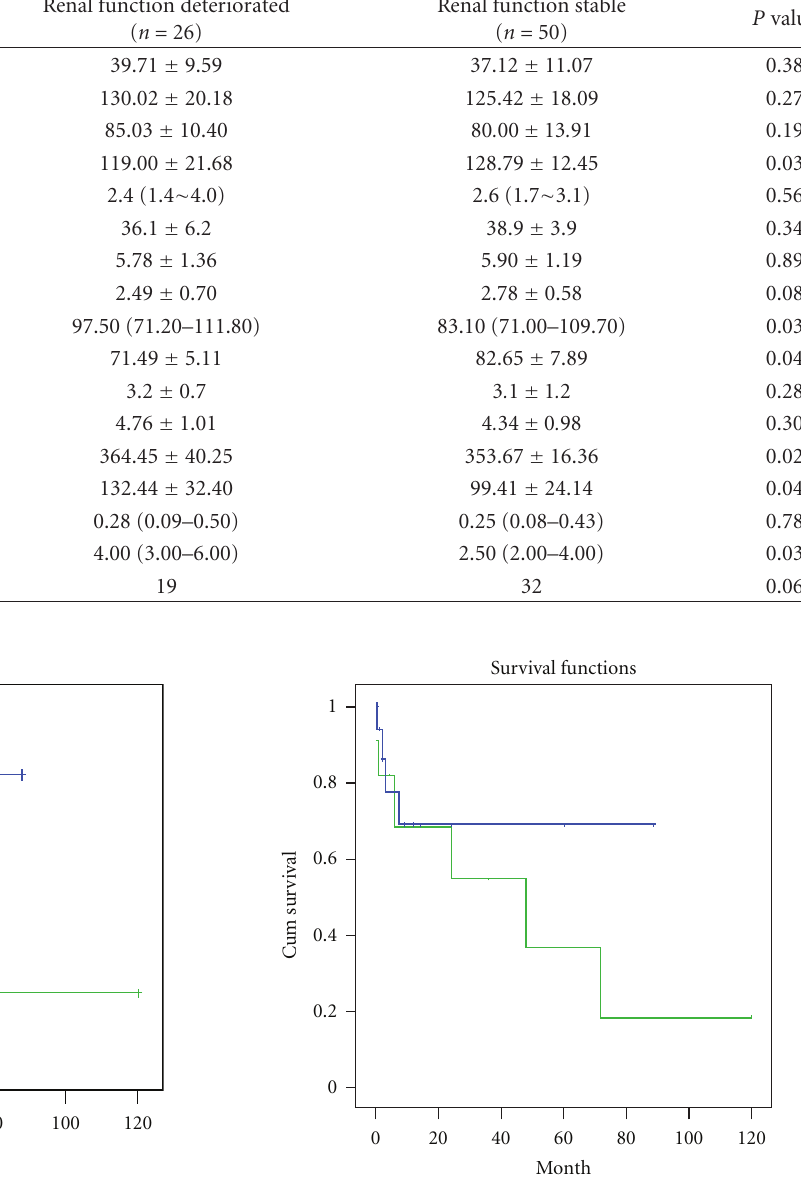
Figure 4: IgAN patients who had higher than median IL-18 levels (346.80pg/mL) at baseline had worse renal outcome in follow-up period (Log rank P = 0 . 03). In this figure, green line represents those patients with higher sIL-18 levels.